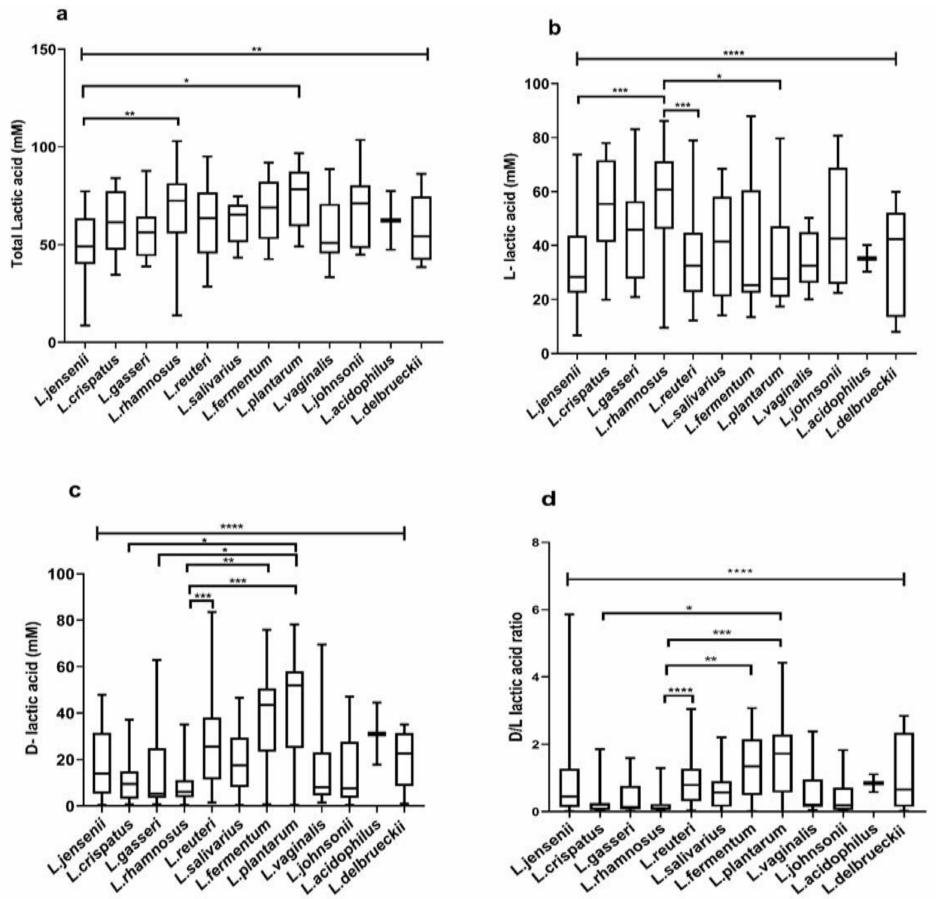
Figure 3. Lactic concentrations: ( a ) total lactic acid, ( b ) d -lactic acid, ( c ) l -lactic acid, ( d ) d - / l -lactic acid ratio of lactobacilli recovered from di ff erent vaginal microbiota. The amount of lactic acid isomers and d - / l -lactic acid ratio of lactobacilli metabolites di ff ered significantly between the groups. * p < 0.05, ** p < 0.01, *** p < 0.001, **** p < 0.0001 indicating statistical significance after performing the Kruskal–Wallis test. The topmost line indicates the Kruskal–Wallis test and downward pointing lines indicate Dunn’s multiple comparison test. Data are represented as a box plot wherein the box indicates the interquartile ranges, line within the bars represents the median and whiskers represent the minimum and the maximum